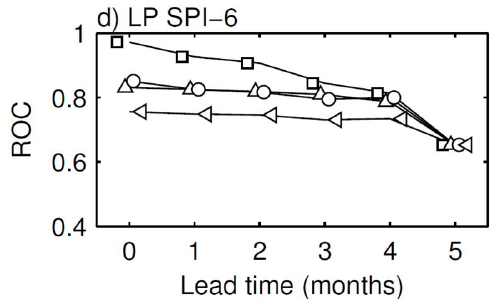
Figure 13. ROC scores of seasonal forecasts of SPI-6 of the Limpopo Basin by Dutra et al. (2013). Lead times have been de- fined differently in the following way: the lead time represents the number of months before the last of the 6 months of SPI-6, meaning a lead time of 0 months would correspond to a forecast of SPI DJFMAM in May; hence, a lead time of 5 months would be equivalent to a lead time of 0 months in this study. The lines indi- cate different precipitation data sets. (Source: Fig. 11d from Dutra et al.,